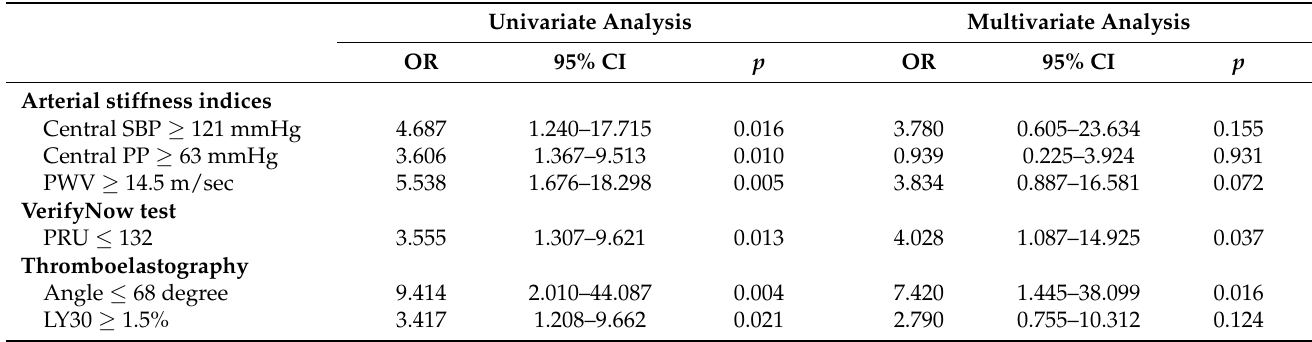
Table 4. Determinants of normal endothelial function (RHI ≥